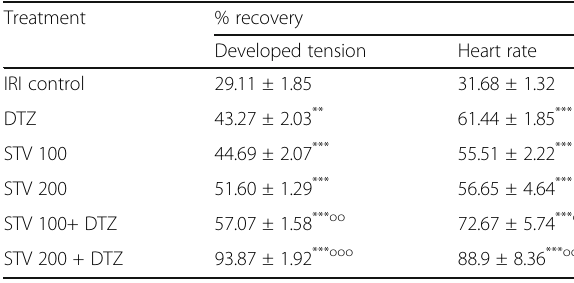
Table 5 Effect of STV, DTZ, and their combinations on % recovery in terms of developed tension and heart rate against IRI damage in